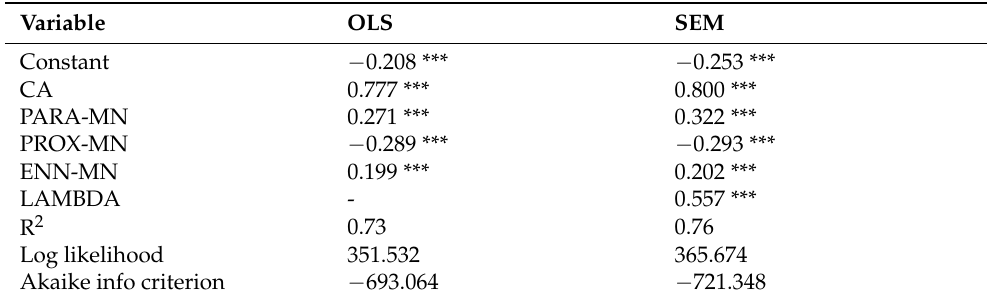
Table 4. Comparison between ordinary least squares (OLS) and spatial error model (SEM) results.